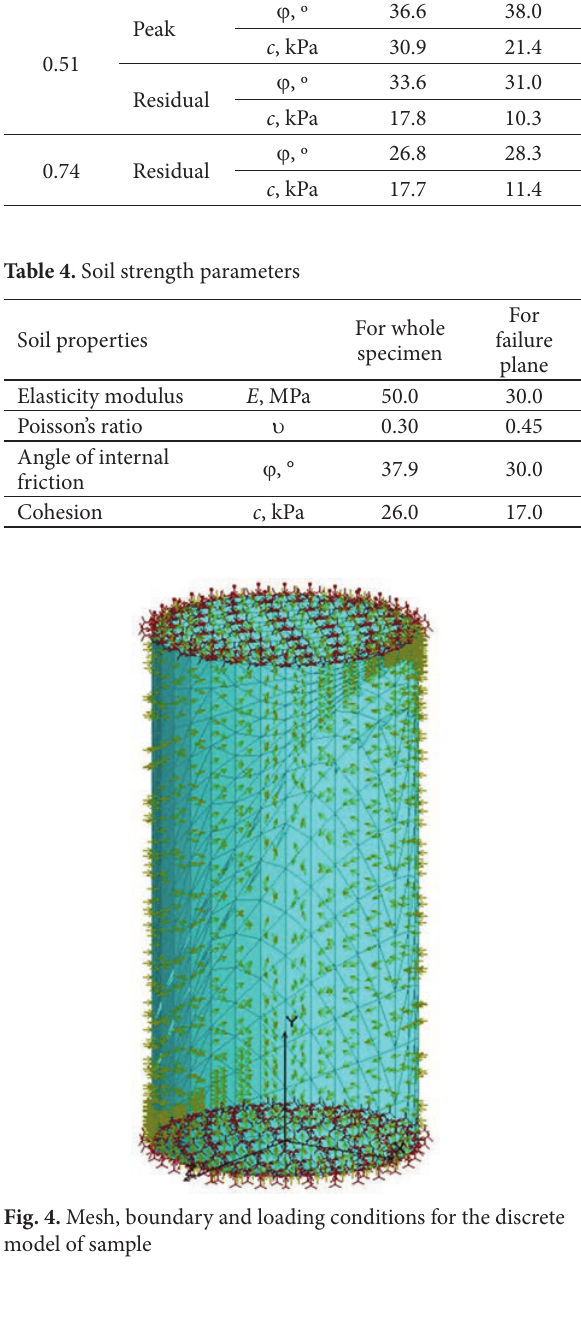
Table 3. Mean values of the soil shear strength parameters j and c Void Shear strength ratio e parameters